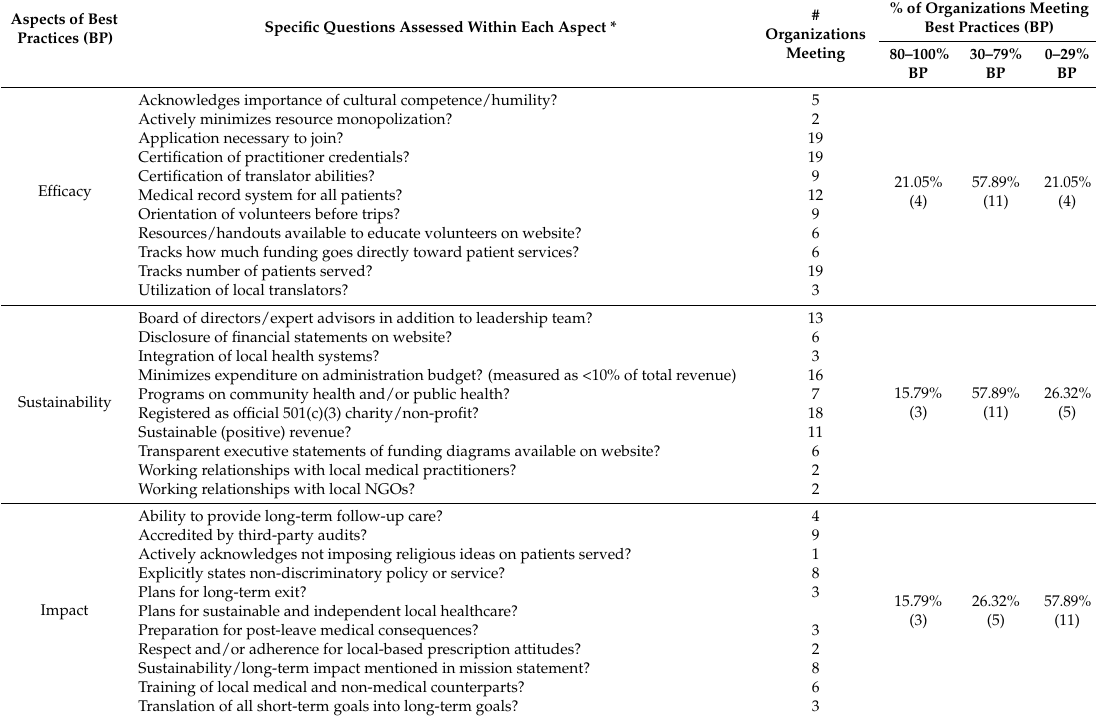
Table 2. Summary of best practices (BP) and breakdown of organizations meeting specific BP